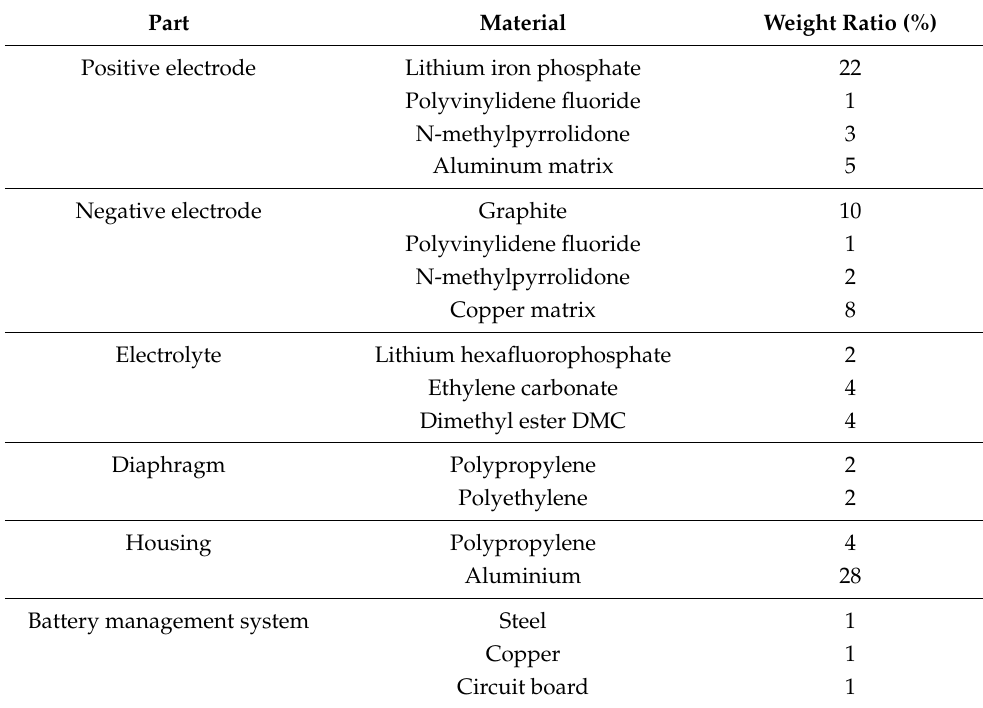
Table 5. Composition and proportion of LFP battery cell.